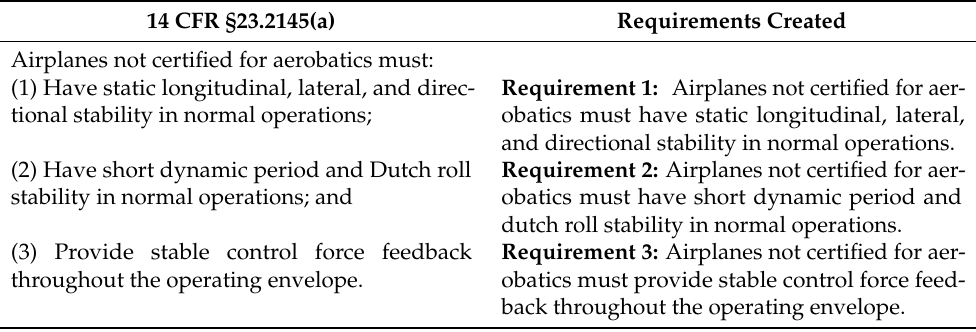
Table 3. Example showing the modification of text from 14 CFR §23.2145(a) into